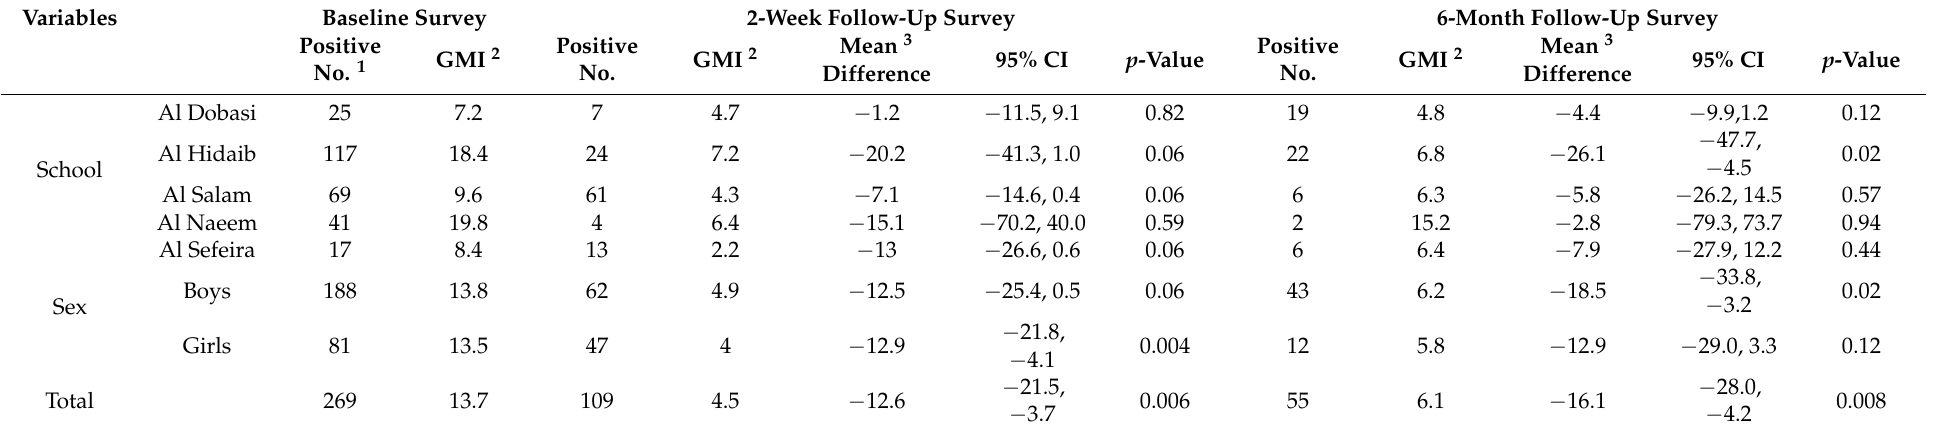
Table 3. The geometric mean intensity (GMI) of S. haematobium -infected